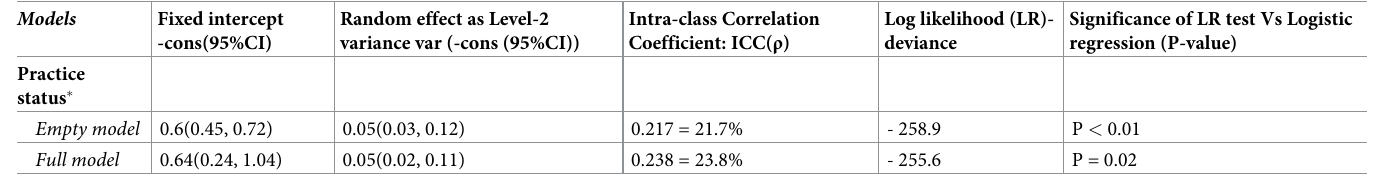
Table 4. Parameter coefficients and test of goodness-of-fit of the mixed-effects multilevel models, Benishangul Gumuz Region, Ethiopia 2020.